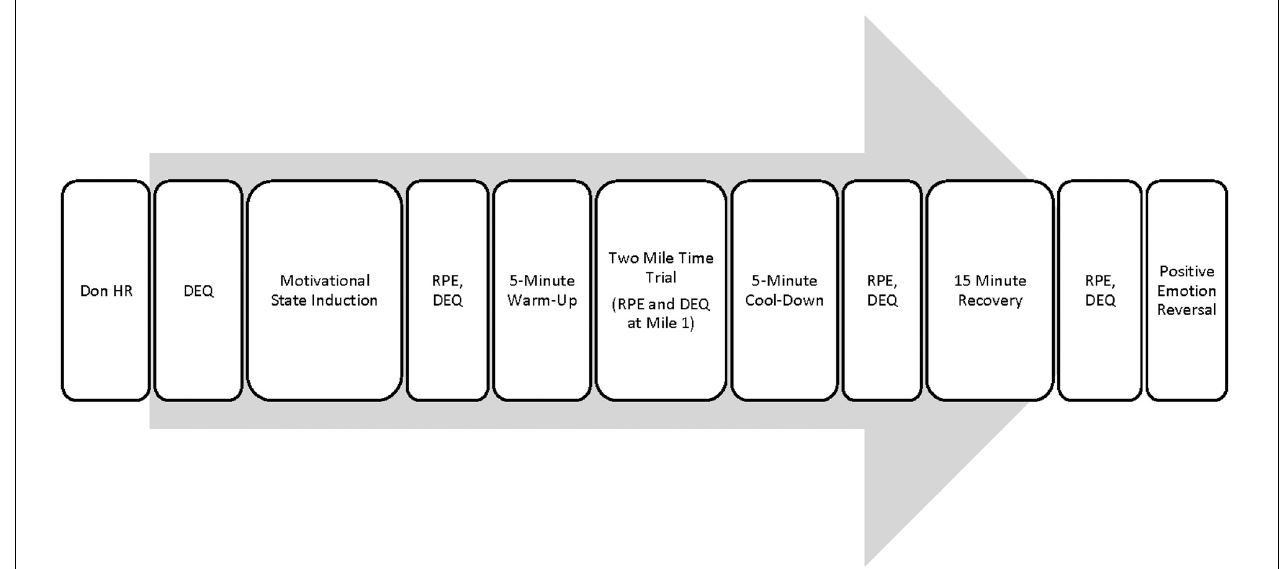
FIGURE 1 | Schematic of Study 2